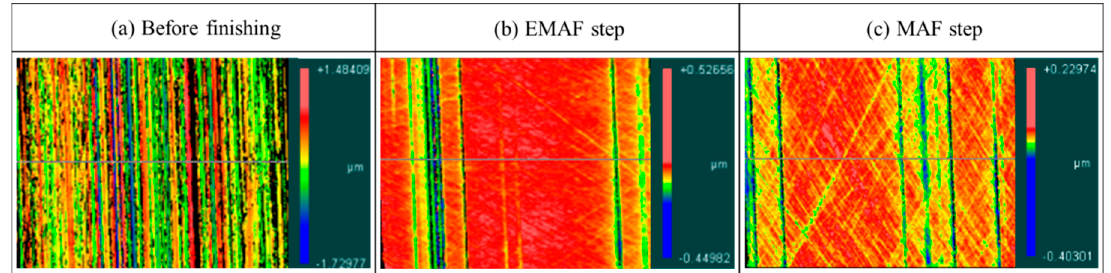
Figure 11. Non-contact three-dimensional (3D) measurement of the unfinished surface and finished surface after different finishing steps under the condition of the combination of the 4-min EMAF step and 26-min MAF step.